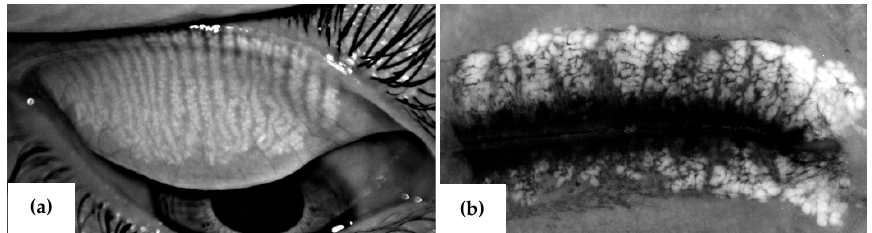
Figure 3. ( a ) Human (upper eyelid) meibomian glands acquired with Oculus® keratograph and ( b ) Mouse (upper and lower eyelids) meibomian glands acquired with a stereo microscope.